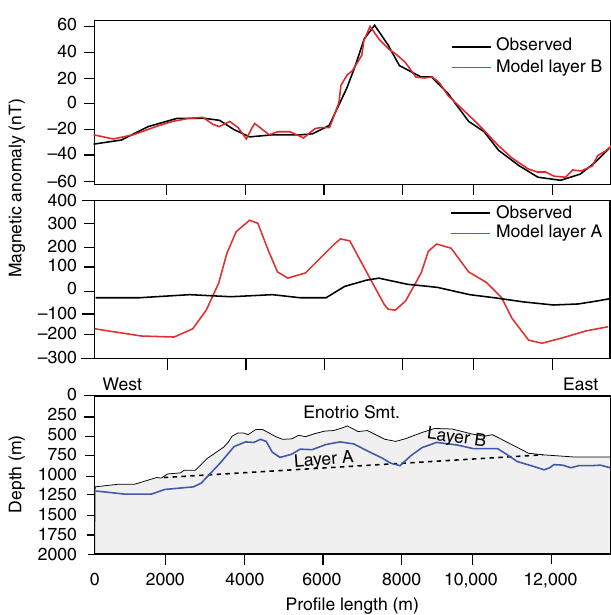
Fig. 9 2.5D magnetic forward models of the Enotrio volcano. Comparison between the recovered model and the observed magnetic anomaly assuming a distribution of high magnetized lava fl ows (5.5 A/m) con fi ned within a layer B (blue continuous line in the bottom panel) and a distribution of the modeled magnetic anomaly pro fi le with a distribution of high magnetized volcanic products (5.5 A/m) constrained between the bathymetry and an gently sloping plane (layer A, black broken line). The bedrock is supposed a continental crust with low magnetization (0.8